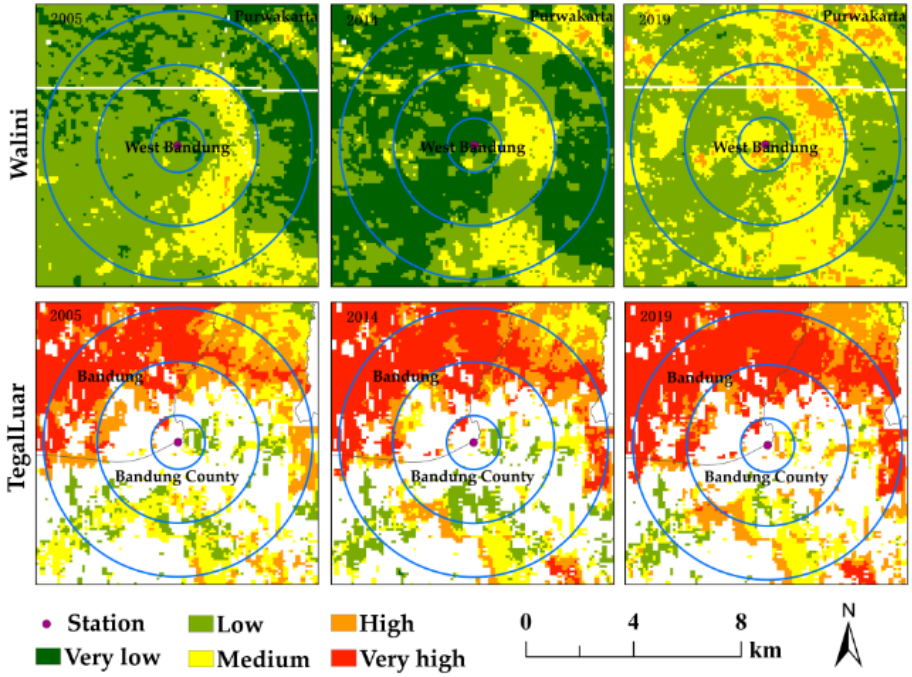
Figure 8. Spatiotemporal variation in the heat wave risk around each Jakarta-Bandung high-speed railway station from 2005 to 2019.